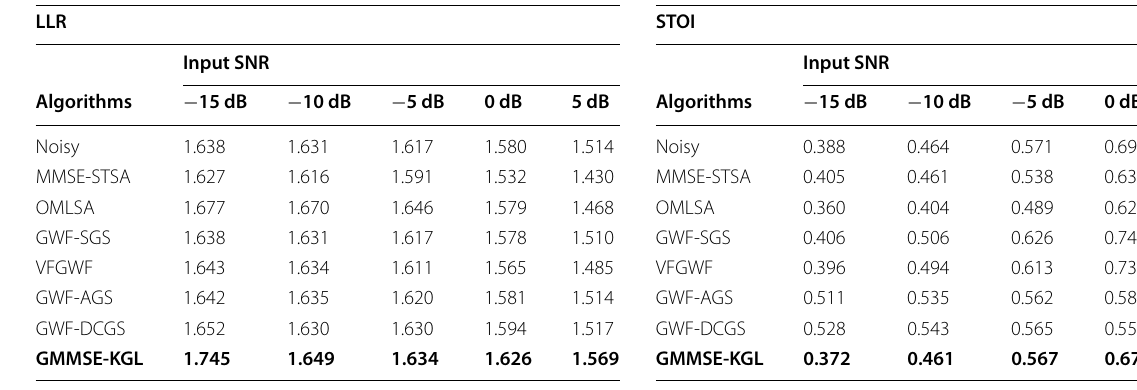
Table 6 The STOI of different methods for white